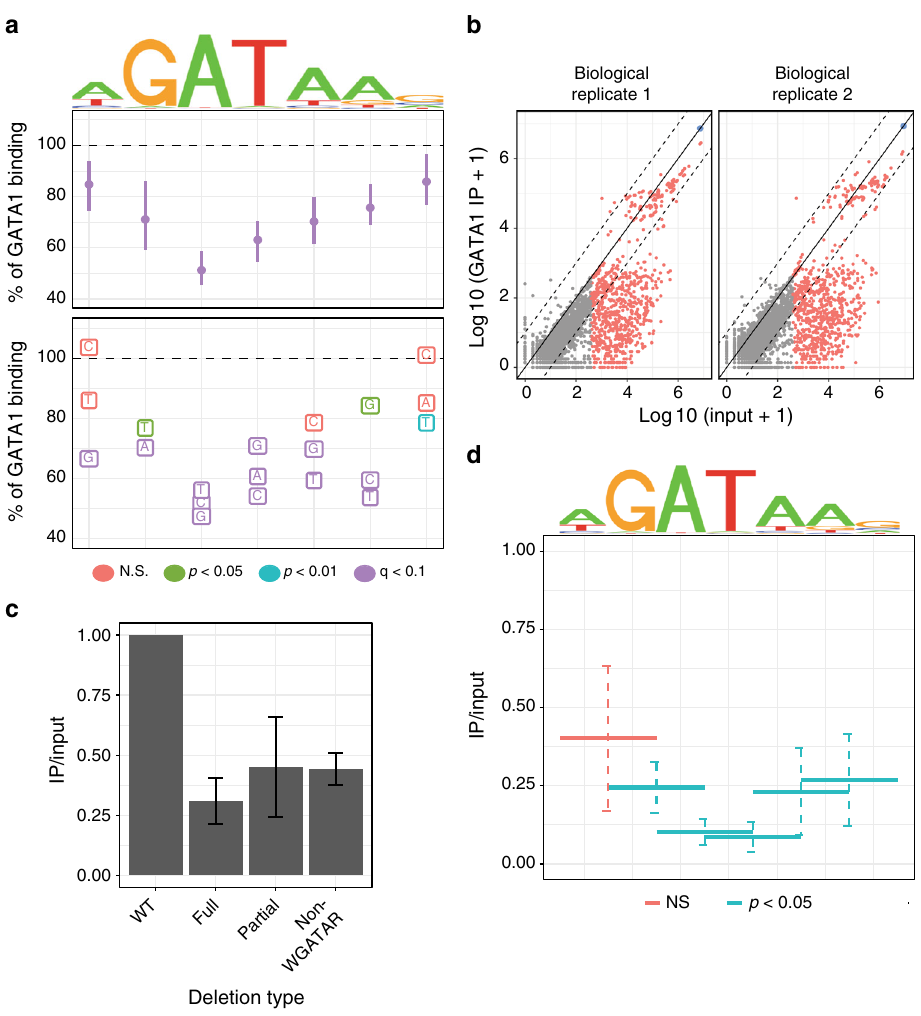
Fig. 3 Genetic variation reveals sequences that directly regulate GATA1 chromatin occupancy. a Sequence logo re fl ecting canonical GATA1 motif and the percent impact on GATA1 binding intensity associated with discSNPs at various positions and to particular alternative nucleotides. Median ± 95% con fi dence intervals by bootstrapping. b Normalized read count in sequenced ChIP input vs GATA1 IP for deletion-containing alleles of the Bola1 -proximal GATA1 peak in MEL cells. Gray points indicate deletions removed due to low Input read counts, red points indicate deletions above the read count threshold, and blue point indicates wild-type (non-deleted) MEL allele. Solid line indicates 1:1 normalized IP enrichment, and dashed lines indicate 10-fold changes in enrichment. c Aggregate effects on GATA1 IP enrichment of either full or partial deletions of the WGATAR motif or of deletions not overlapping this motif, mean ± SEM. d Aggregate effects of 1-bp or 2-bp deletions within a 2-bp sliding window across the GATA1 motif on GATA1 IP enrichment, mean ±